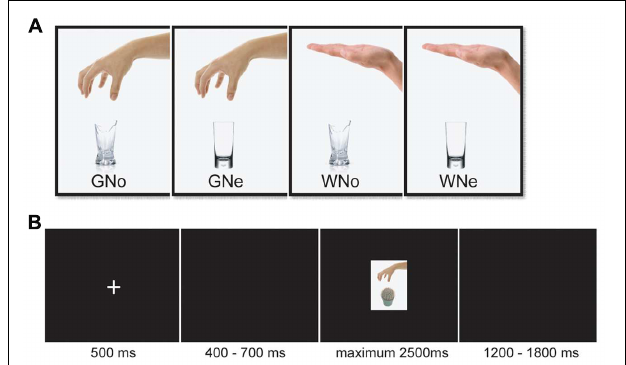
FIGURE 1 | (A) Examples of pictures in each condition (B) an example from one trial.